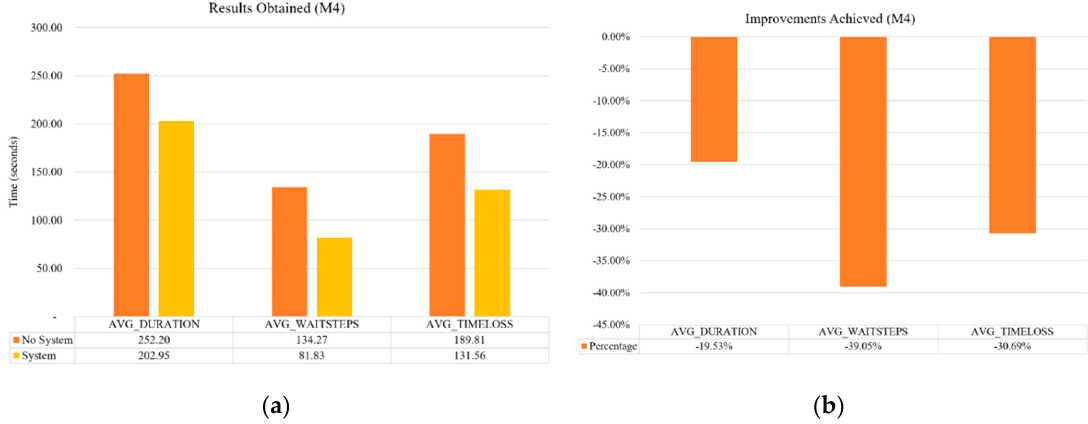
Figure 6. ( a ) Results obtained for M4 network, both without using the proposal (no system) and using it (system); ( b ) reductions obtained for different time measures.